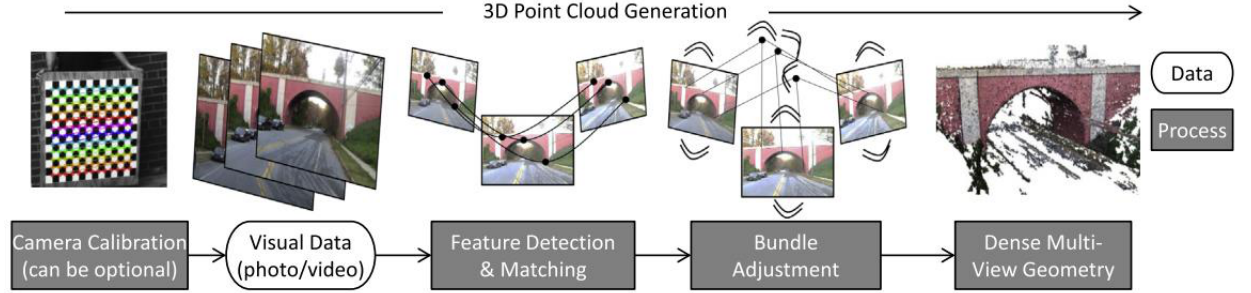
Figure 2. Schematic process for image-based 3D point cloud generation [17].